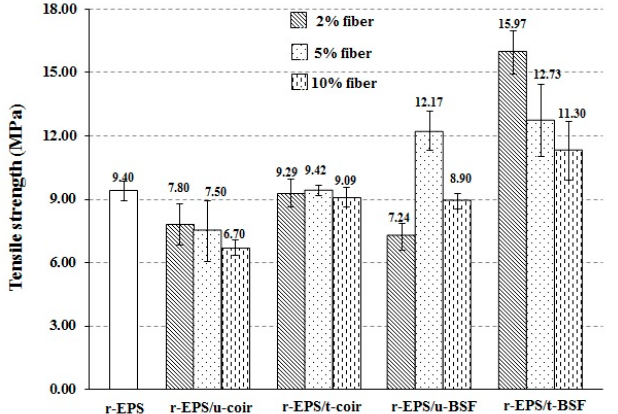
Figure 5. Tensile strengths of r-EPS composites with untreated and treated BSF or coir fibers at 2%, 5%, or 10% wt. loadings.